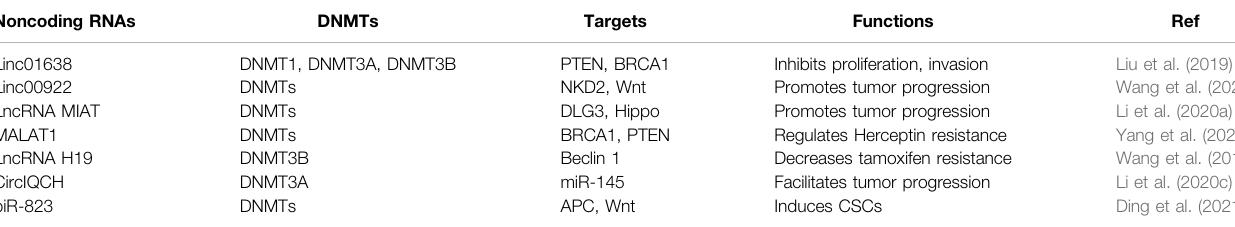
TABLE 3 | LncRNAs and circRNAs regulate DNMTs in breast cancer. Noncoding